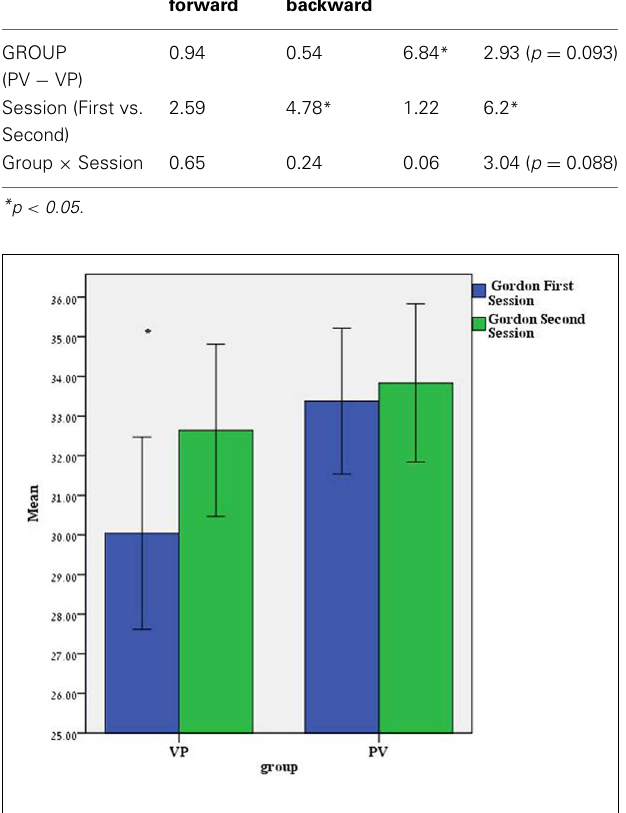
FIGURE 1 | Mean scores for the Gordon music test in the first and second sessions in the two groups of subjects. The group receiving Vasopressin in the first session (PV, N subjects = 24) performed significantly worse than the group receiving placebo in this session (PV, N subjects = 25). No such differences were noted in the second session. ∗ p = 0 .